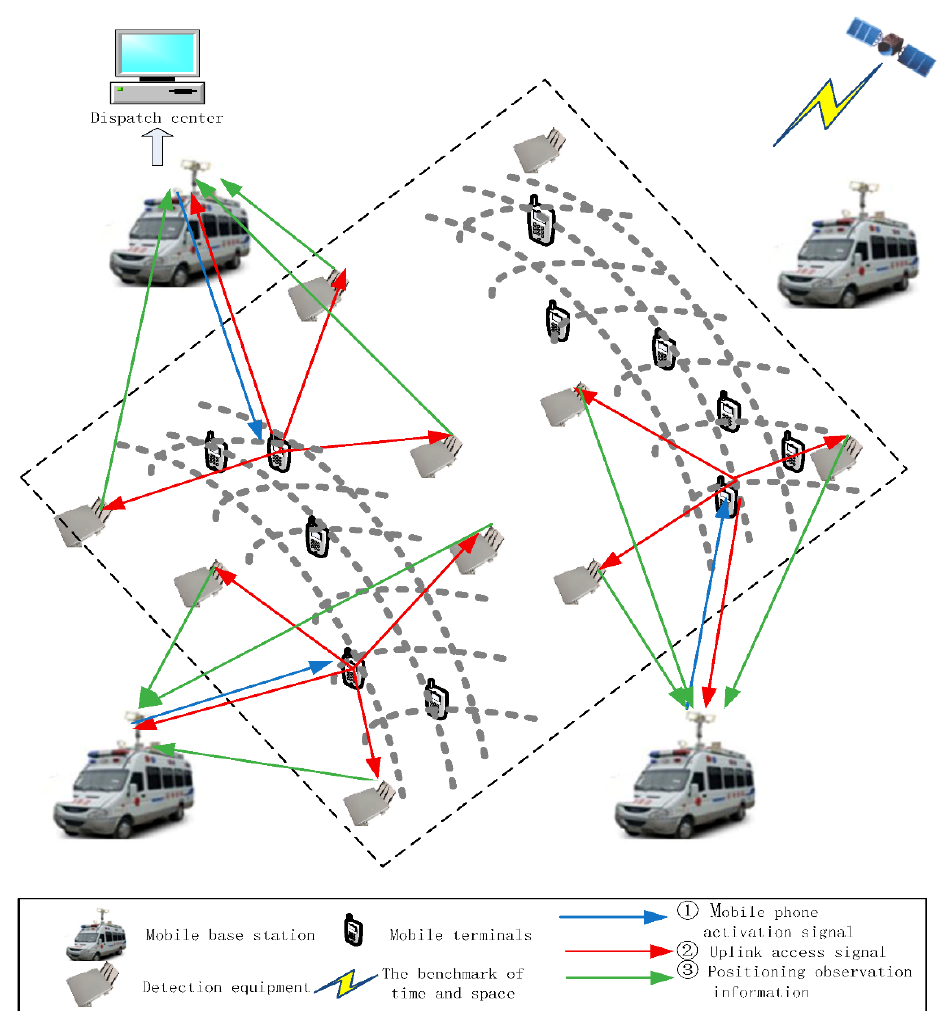
Figure 1. Architecture of post-disaster search-and-rescue positioning system.